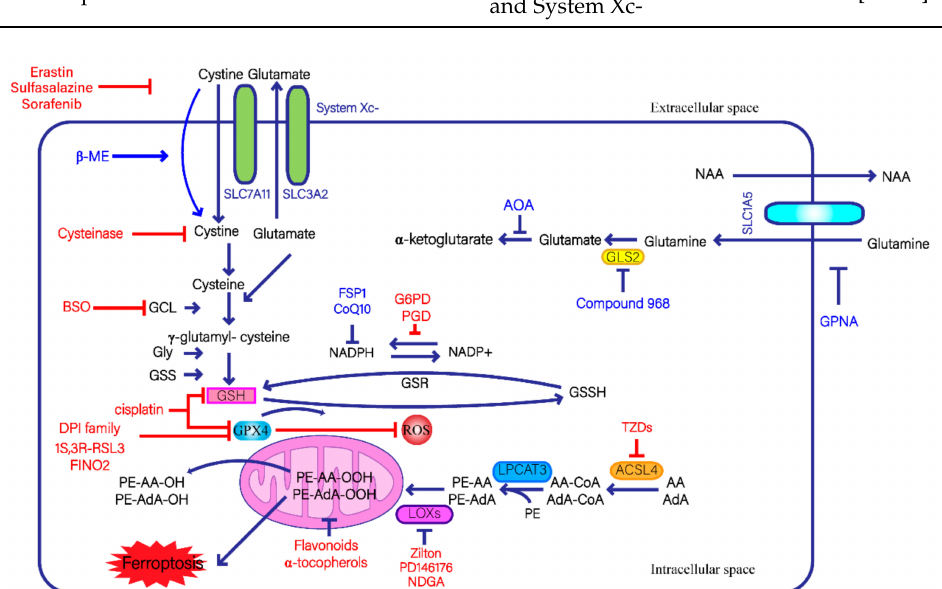
Figure 1. The signaling pathways and regulatory mechanisms of lipid-peroxidation-mediated fer- roptosis. The lines and text in red denote ferroptosis inducers, while the lines and text in blue denote ferroptosis inhibitors. System Xc- consists of SLC7A11 and SLC3A2. SLC1A5 is a glutamine importer [62]. GSH is synthesized from Cys, Glu, and Gly in two steps: firstly, the ATP-dependent cytosolic enzyme GCL synthesizes γ -glutamyl-cysteine from Gln and Cys; secondly, GSS synthe- sizes GSH from γ -glutamyl-cysteine and Gly. GPX4 and GSH can prevent lipid ROS accumulation. GSH reductase utilizes NADPH to reduce GSSG to GSH. ACSL4 utilizes AA and AdA to synthe- size AA-CoA and AdA-CoA. LPCAT3 catalyzes ACSL4-synthesized AA-CoA and AdA-CoA into PE species. Lipoxygenase oxidizes PE species into PUFA-OOHs. Lastly, GPX4 catalyzes the lipid hydroperoxides PUFA-OOHs into lipid alcohols